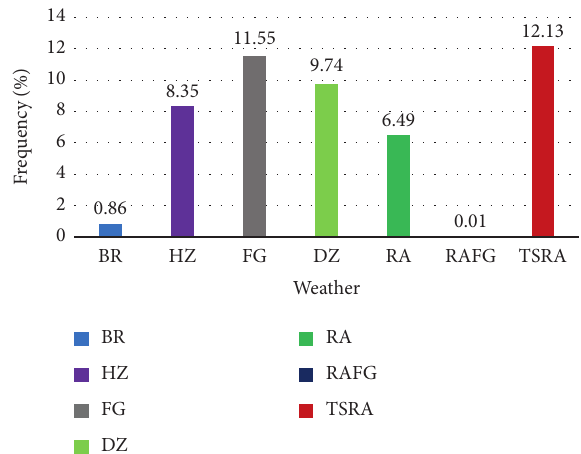
Figure 11: Maximum frequency (%) of weather occurrences by phenomenon